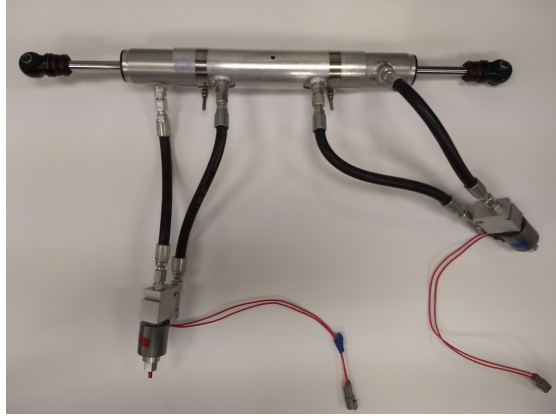
Figure 1. Semi-Active Double Damper.